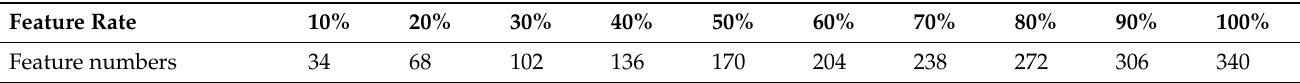
Figure 10. The experimental process of feature selection by utilizing the six feature selection methods and by utilizing the k -NN classifier with different k values. Table 7. The number of